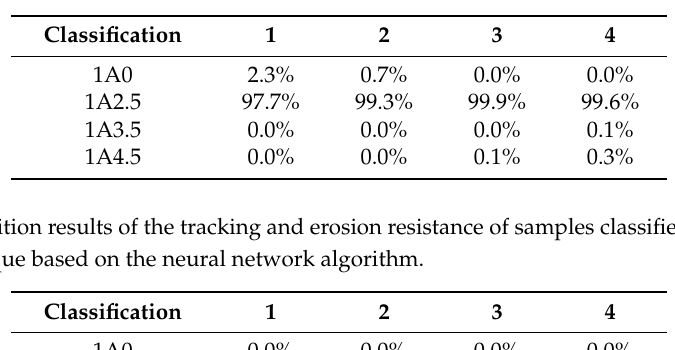
Table 7. Recognition results of the tracking and erosion resistance of samples classified as 1A2.5 using the LIBS technique based on the neural network algorithm.